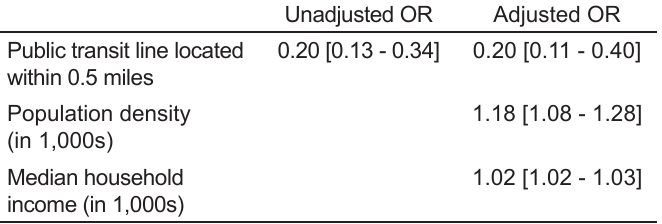
Table 2. Logistic regression of the likelihood of freestanding emergency departments being located within 0.5 miles of public transit relative to hospital emergency departments.